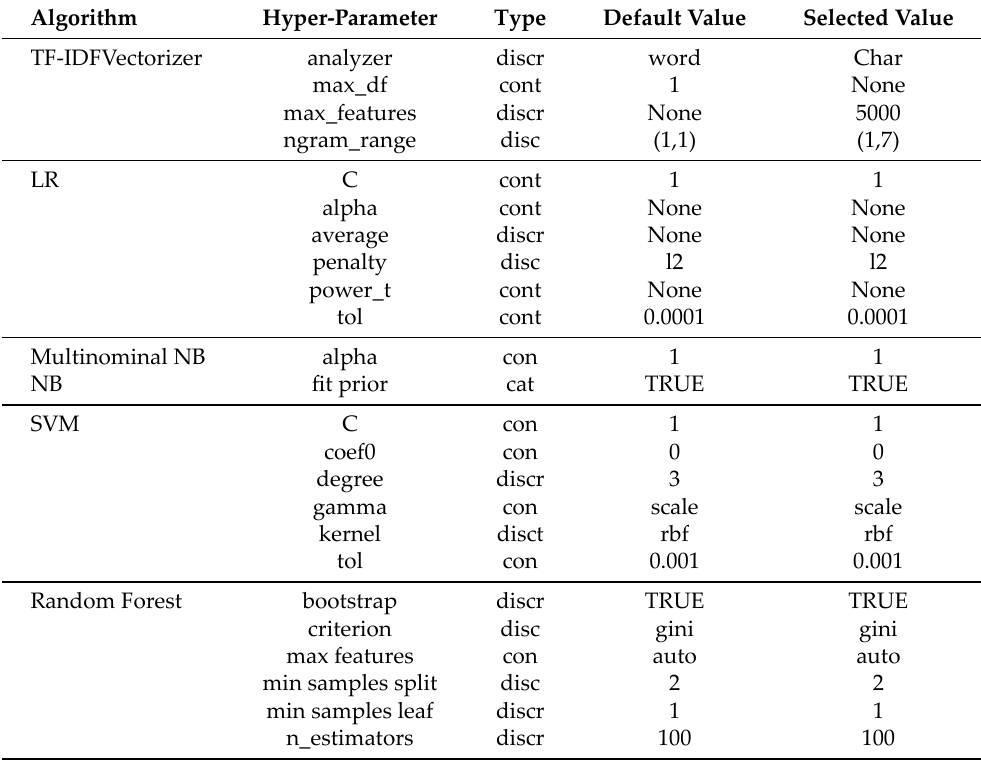
Table 3. Hyperparameter of the base learners and the TF‑IDF